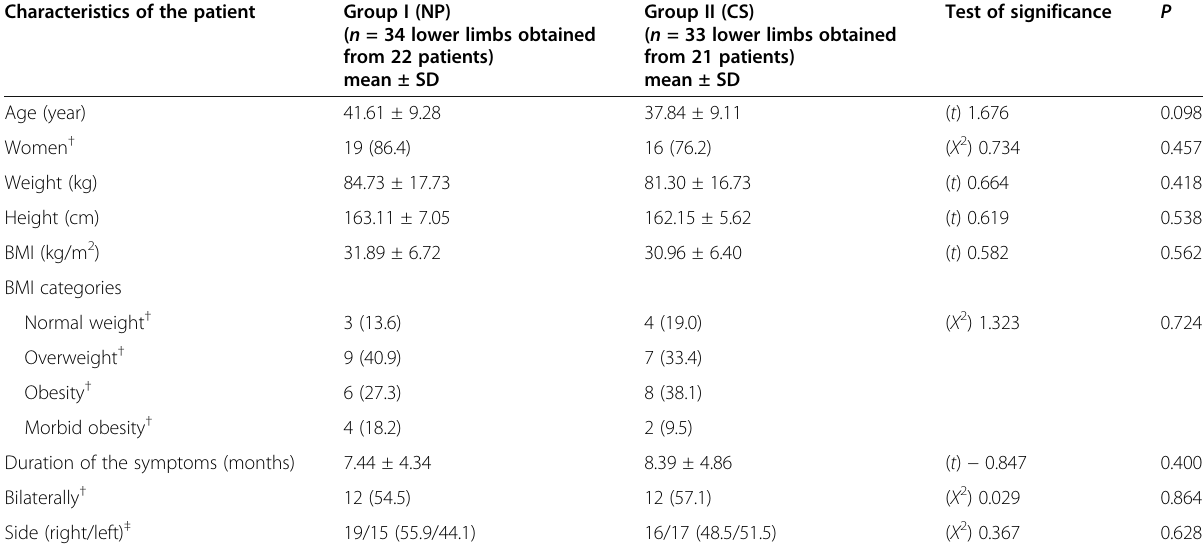
Table 1 Characteristics of the patients in the two treatment groups Characteristics of the